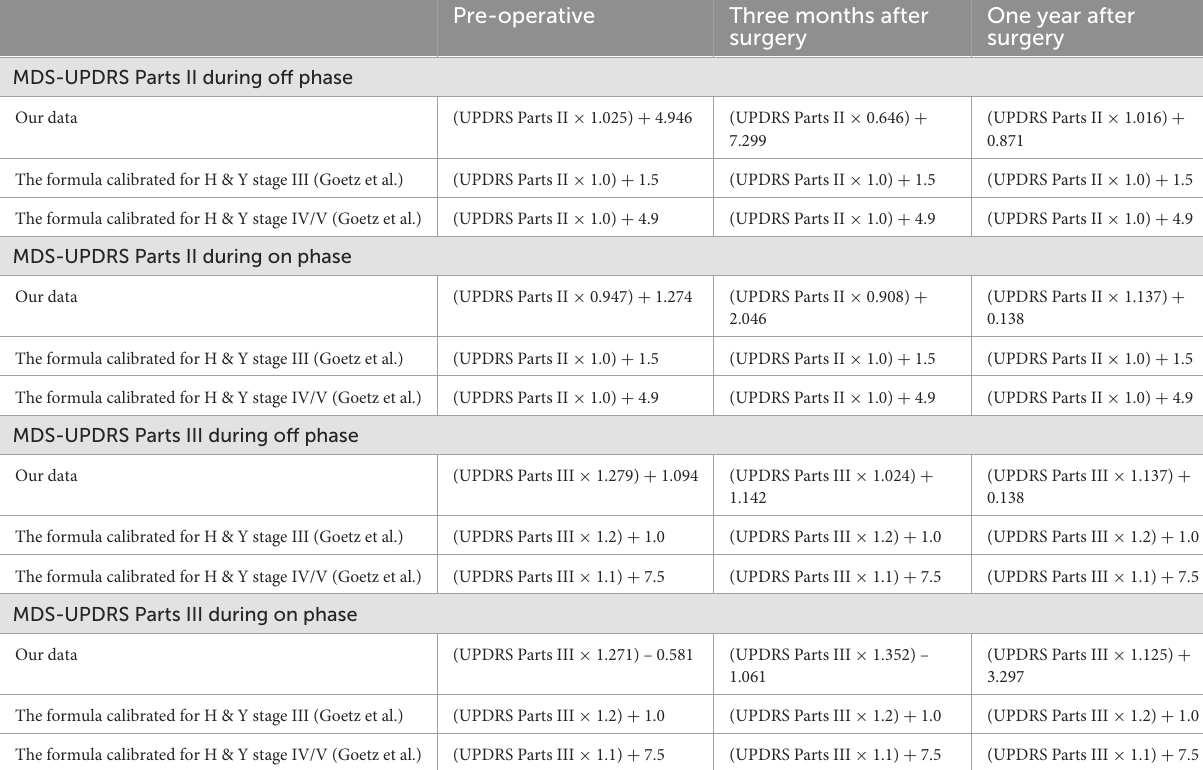
TABLE 4 Conversion formula calculating estimated MDS-UPDRS score from UPDRS